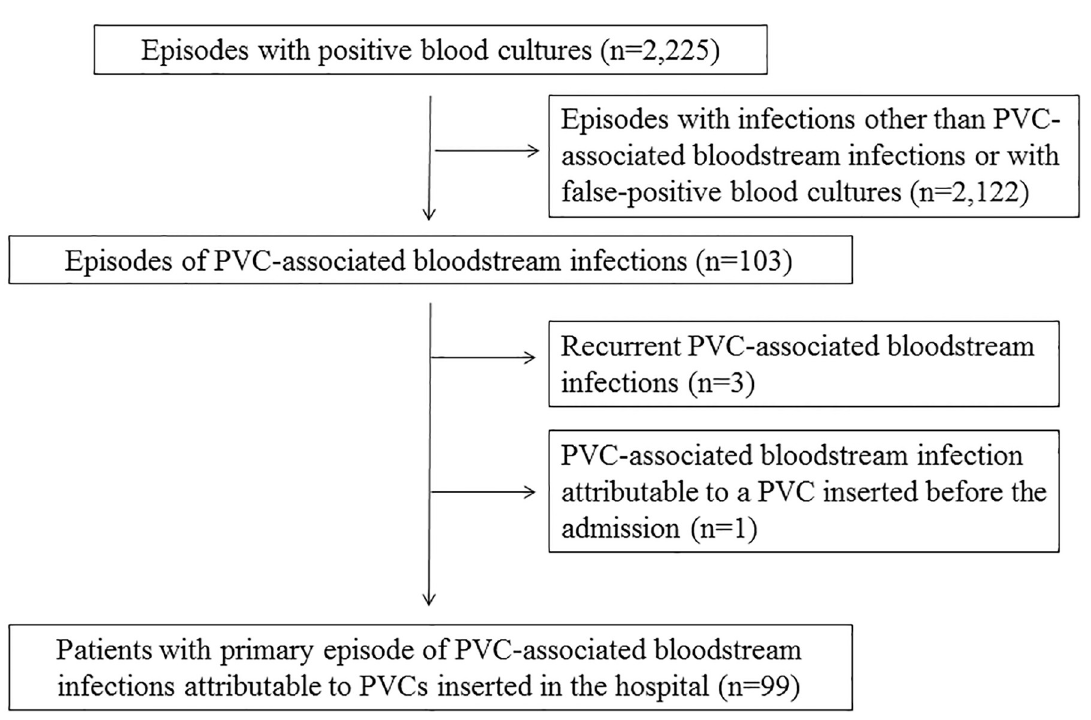
Fig 1. Flow chart of patients included in the study. PVC, peripheral intravenous catheter.